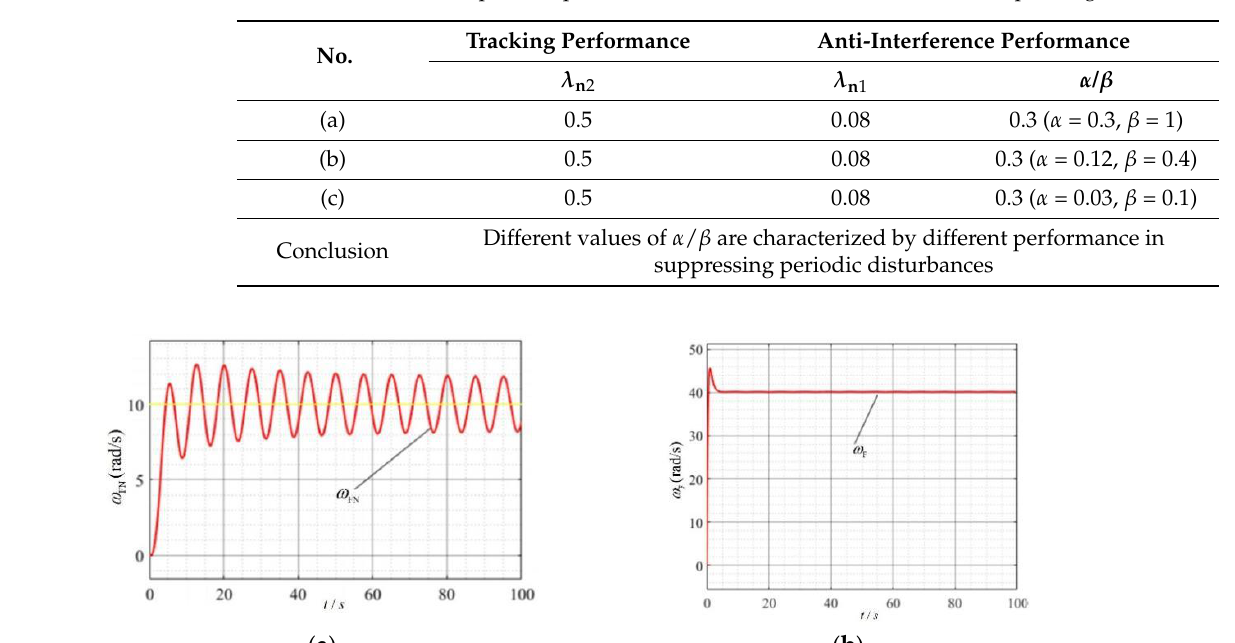
Table 8. Two schemes of periodic perturbation of drivetrain vibration with corresponding conclusions.